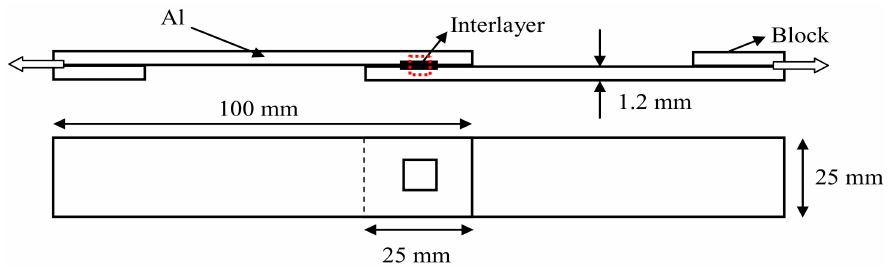
Figure 4. Diagram of welding sheet and design of the tensile shear test